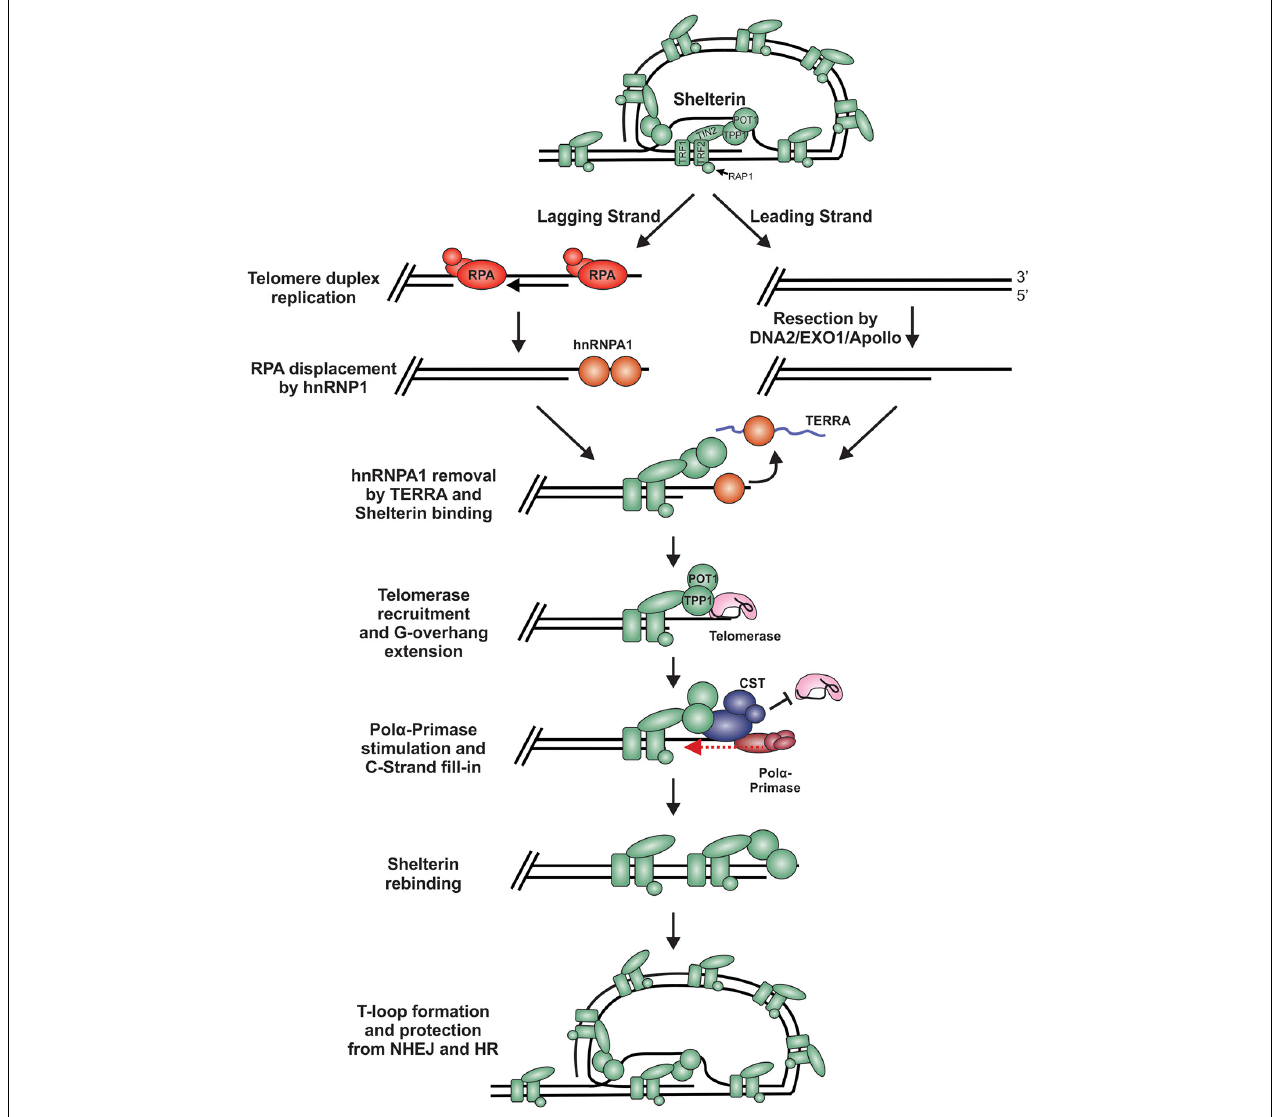
FIGURE 7 | Model of telomere replication and end protection. During telomere replication, t-loops are resolved exposing chromosome ends to potential repair mechanisms. On the lagging strand, regions of ssDNA are bound by RPA as part of the normal replication process. To prevent stable RPA binding, an RPA-to-POT1 switch is facilitated by hnRNPA1. TERRA then removes hnRNPA1 to allow POT1 binding. On the leading strand, blunt telomere ends are resected by DNA2, EXO1 and/or Apollo to generate a G-overhang. (RPA may also bind to these ends and require removal). Telomerase is localized to the telomeres through its interaction with TPP1 to extend the G-overhang. To prevent G-overhang hyperextension, CST is localized to telomeres by TPP1 and inhibits telomerase activity. Additionally, CST promotes C-strand fill-in by stimulating pol α . After telomere processing, t-loops are reformed to protect the chromosome end from DSB